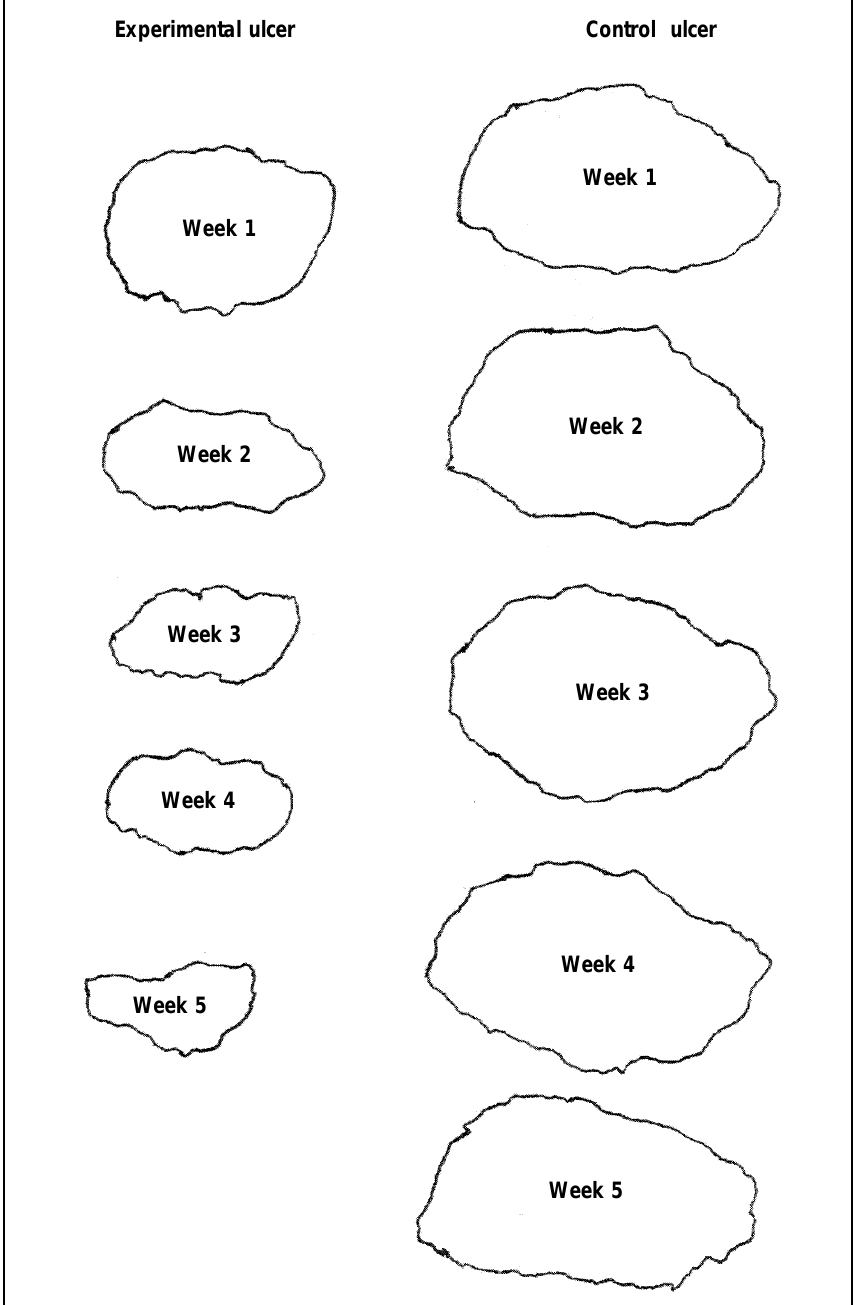
Figure 1: Weekly tracings of experimental and control ulcers surface area. Experimental